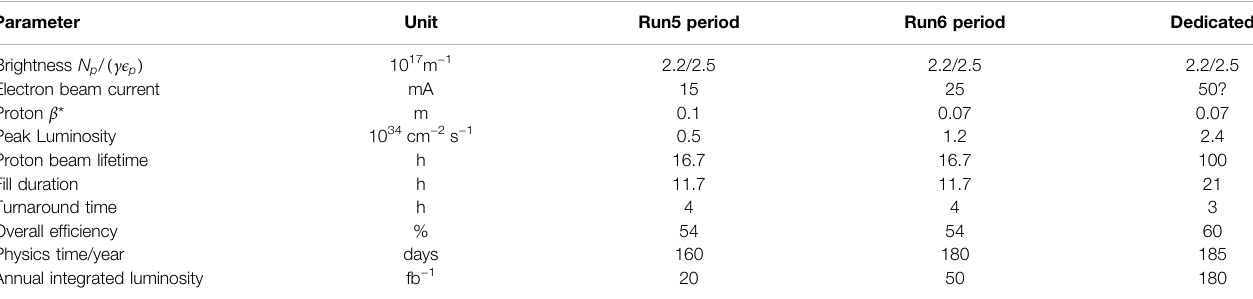
TABLE 1 | The LHeC performance levels during different operation